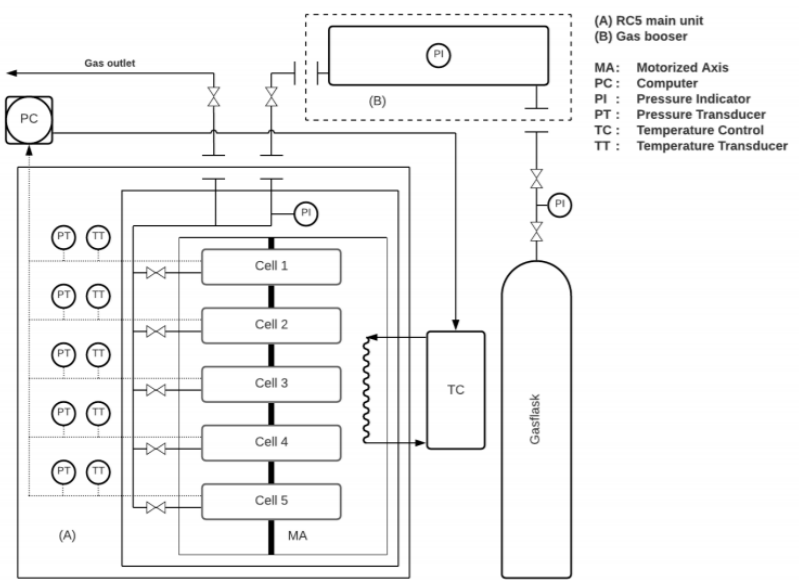
Figure 1. Schematic of rocking cell setup procured from PSL Systemtechnik Germany.